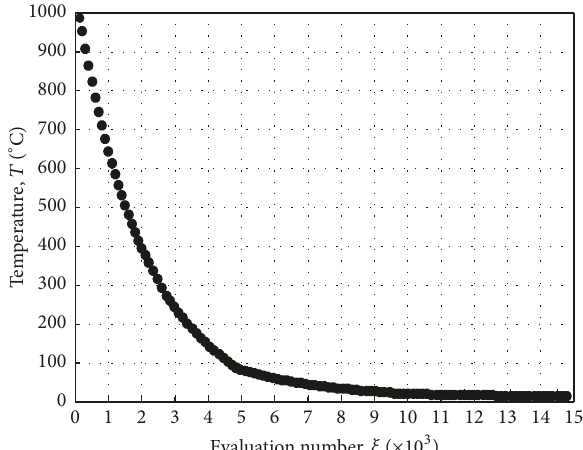
Figure 7: Behavior of the temperature in relation to iterations.